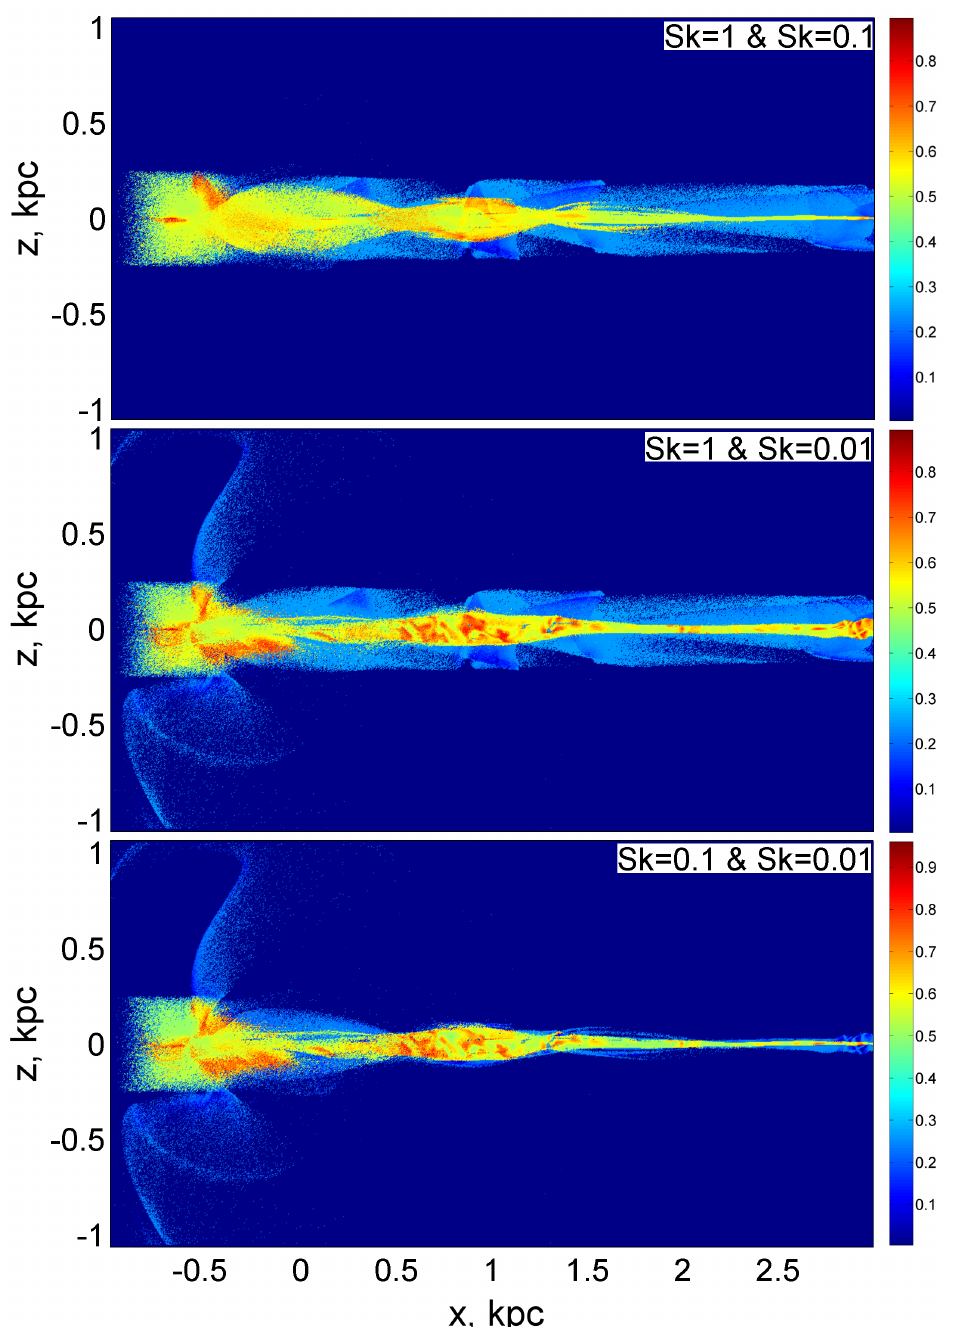
Figure 2. Distributions of the surrogate entropy for a mixture of particles of coarse and medium fractions (upper figure), a mixture of particles of coarse and fine fractions (middle figure), and a mixture of medium and fine particle fractions (lower